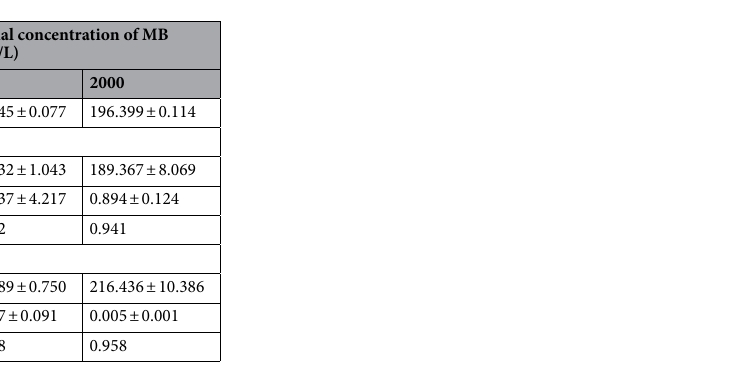
Table 4. Experimental maximum capacity and calculated isotherm parameters for the adsorption of MB onto N g